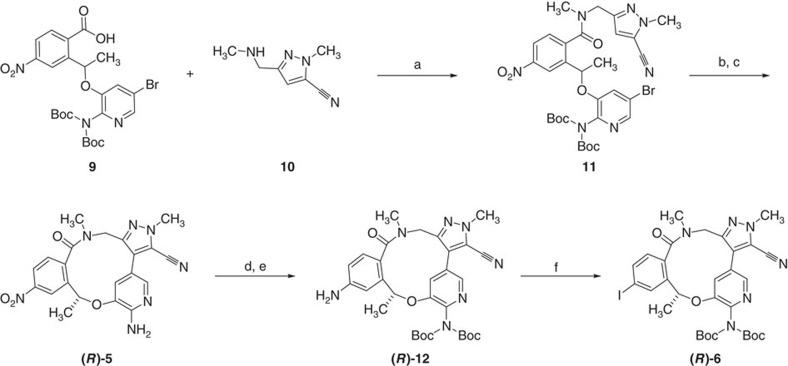
Direct arylation approach to (R)-5 and (R)-6.Reagents and conditions: (a) 1.5 eq pyrazole 10, 2 eq T3P (50% in EtOAc), 4 eq TEA, 2-MeTHF, room temperature (rt), 5 h, 79%; (b) 8 mol% CataCXium A, 8 mol% Pd(OAc)2, 3 eq KOAc, 1 eq H2O, t-AmOH, reflux, 16 h; (c) 4 M HCl/EtOAc, EtOAc, rt, 56 h, 71% over two steps, chiral purification by SFC; (d) 10 eq (Boc)2O, 0.5 eq DMAP, CH2Cl2, 25 °C, 16 h, 76%; (e) 8 eq Na2S2O4, 8 eq NaHCO3, H2O/THF (1:1), 20 °C, 16 h, 58%; (f) 2 eq isoamyl nitrite, 2 eq CH2I2, CH3CN, 80 °C, 4 h, 21%.